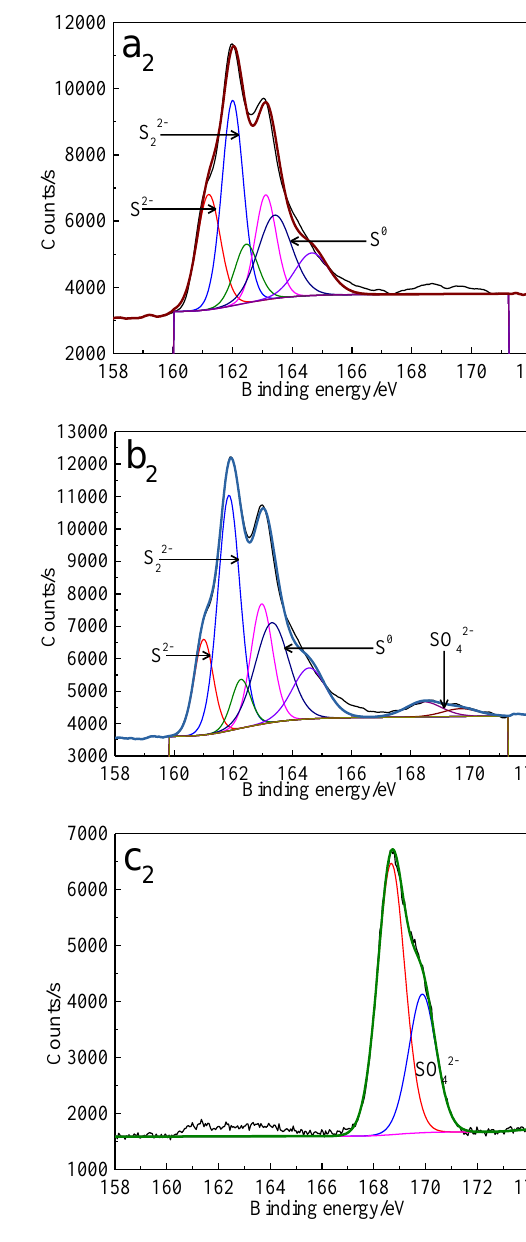
Figure 19. XPS spectra of S 2p peaks of bornite surface leached by A. caldus , L. ferriphilum and mixed culture consisting of A. caldus and L. ferriphilum for 7 and 21 days, respectively (Implemented on the model of ESCALAB 250Xi of Al Kα X-ray source with 20 eV constant pass energy and 0.1 eV/step; Fitted by Thermo Avantage 5.52, C 1s 284.8 eV as reference, Shirley method, Gaussian-Lorentzian function): ( a 1 )- A. caldus and 7 days; ( a 2 )- A. caldus and 21 days; ( b 1 )- L. ferriphilum and 7 days; ( b 2 )- L. ferriphilum and 21 days; ( c 1 )- mixed culture and 7 days; ( c 2 )- mixed culture and 21 days. Table 6. Binding energy and FWHM value for XPS spectra of S 2p 3/2 peaks of bornite leached by A. caldus , L. ferriphilum and mixed culture consisting of A. caldus and L. ferriphilum for 7 and 21 days, respectively (Implemented on the model of ESCALAB 250Xi of Al K α X-ray source with 20 eV constant pass energy and 0.1 eV/step; Fitted by Thermo Avantage 5.52, C 1s 284.8 eV as reference, Shirley method, Gaussian-Lorentzian function) (FWHM means full width at half maximum, B.E. means binding energy).